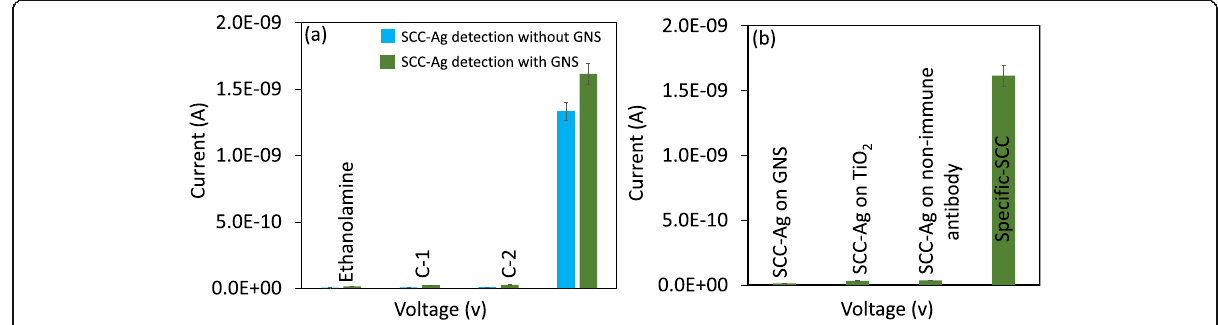
Fig. 7 a Selective detection of SCC-Ag on antibody- and GNS antibody-modified surfaces. Interactions with C1-serpin and C-2-albumin were performed. The surface is with the above steps until 1 M of ethanolamine blocking. Values were averaged by triplicates. In both cases, antibody only recognised the SCC-Ag, indicating the specific detection. b Control measurements. Specificity interactions are compared with non-specific interactions. There were clear discriminations noticed. A linear sweep voltage of 0 to 2 V at 0.01 V step voltage was followed for the measurements. Error bar indicates the averaged values from triplicates ( n = 3) with the standard deviations in the range of ± 0.1 to 0.15 × 10 − 9